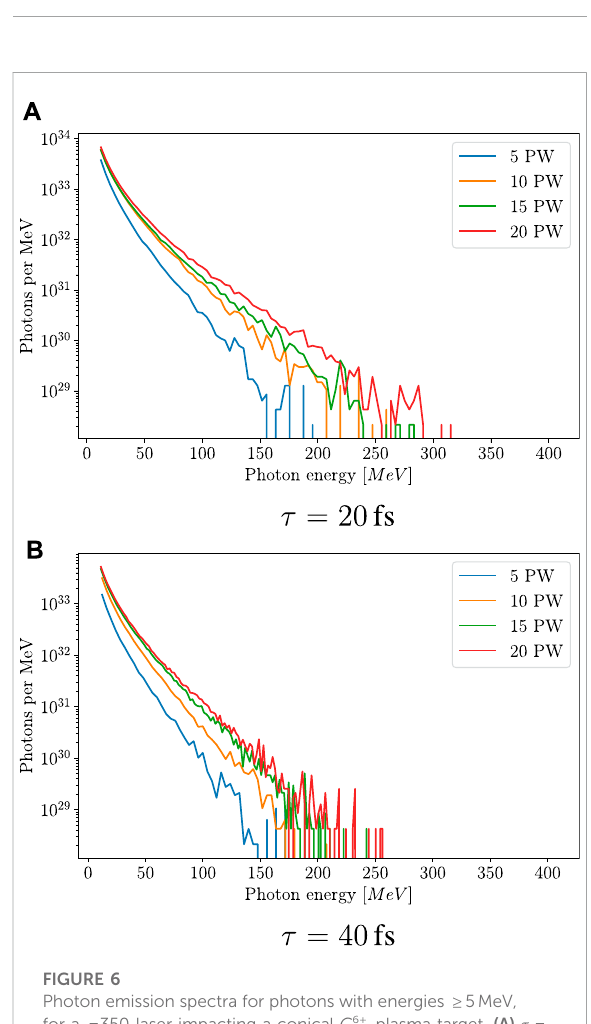
FIGURE 6 Photon emission spectra for photons with energies ≥ 5MeV, for a 0 =350 laser impacting a conical C 6+ -plasma target. (A) τ = 20 fs (B) τ = 40 fs